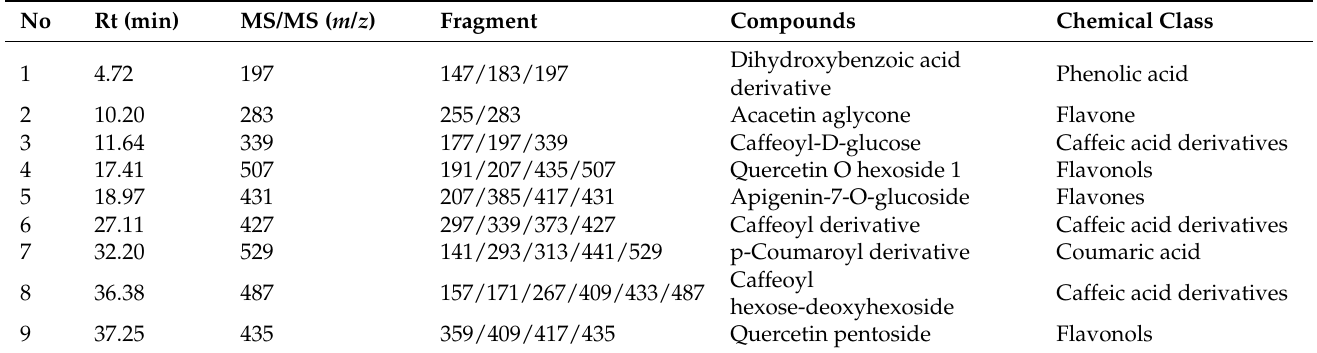
Table 4. Identification of phenolic compounds of J. regia husk extracts using